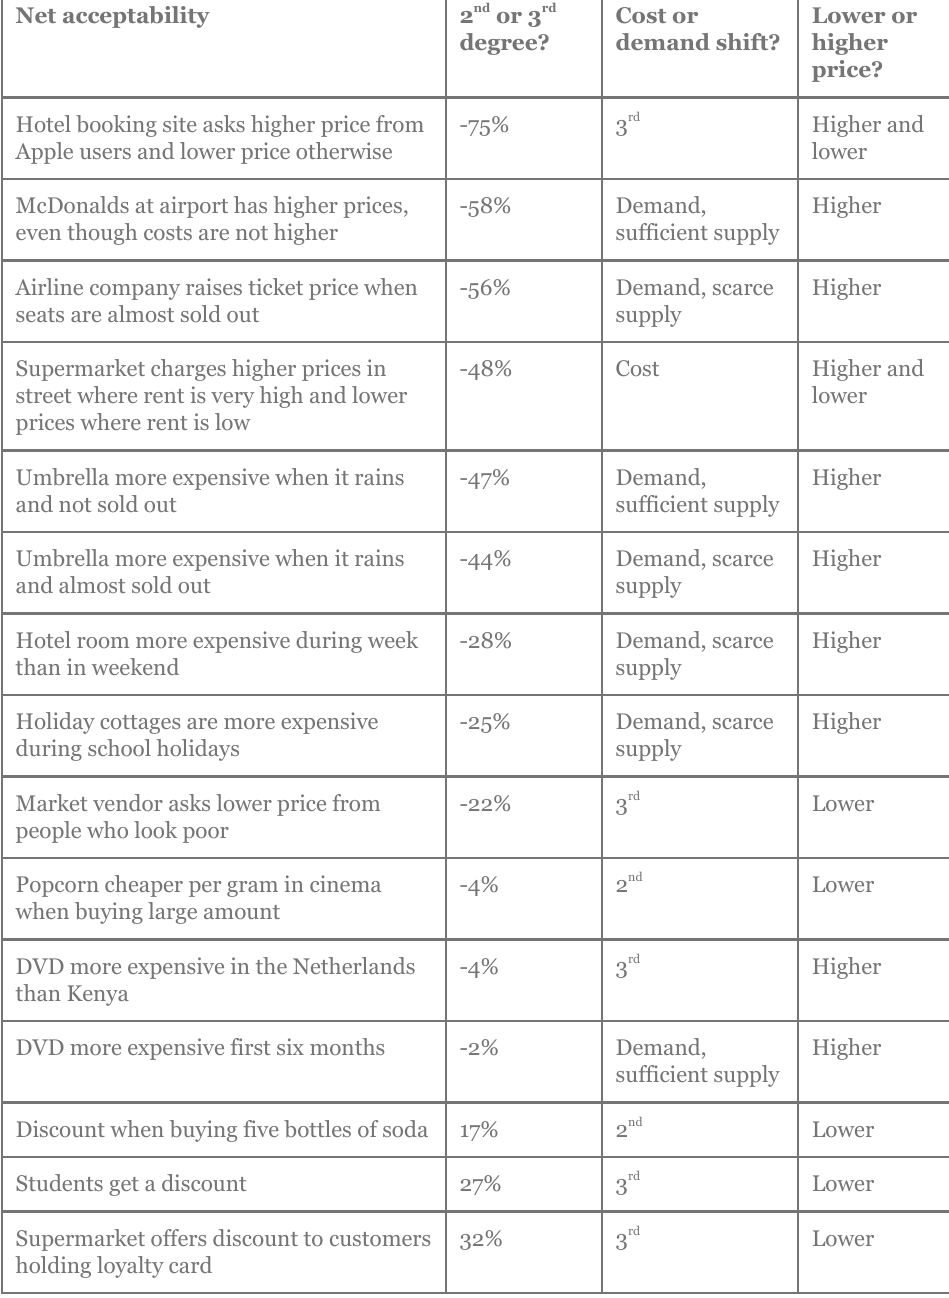
Table 1: Characteristics of examples of price discrimination and dynamic